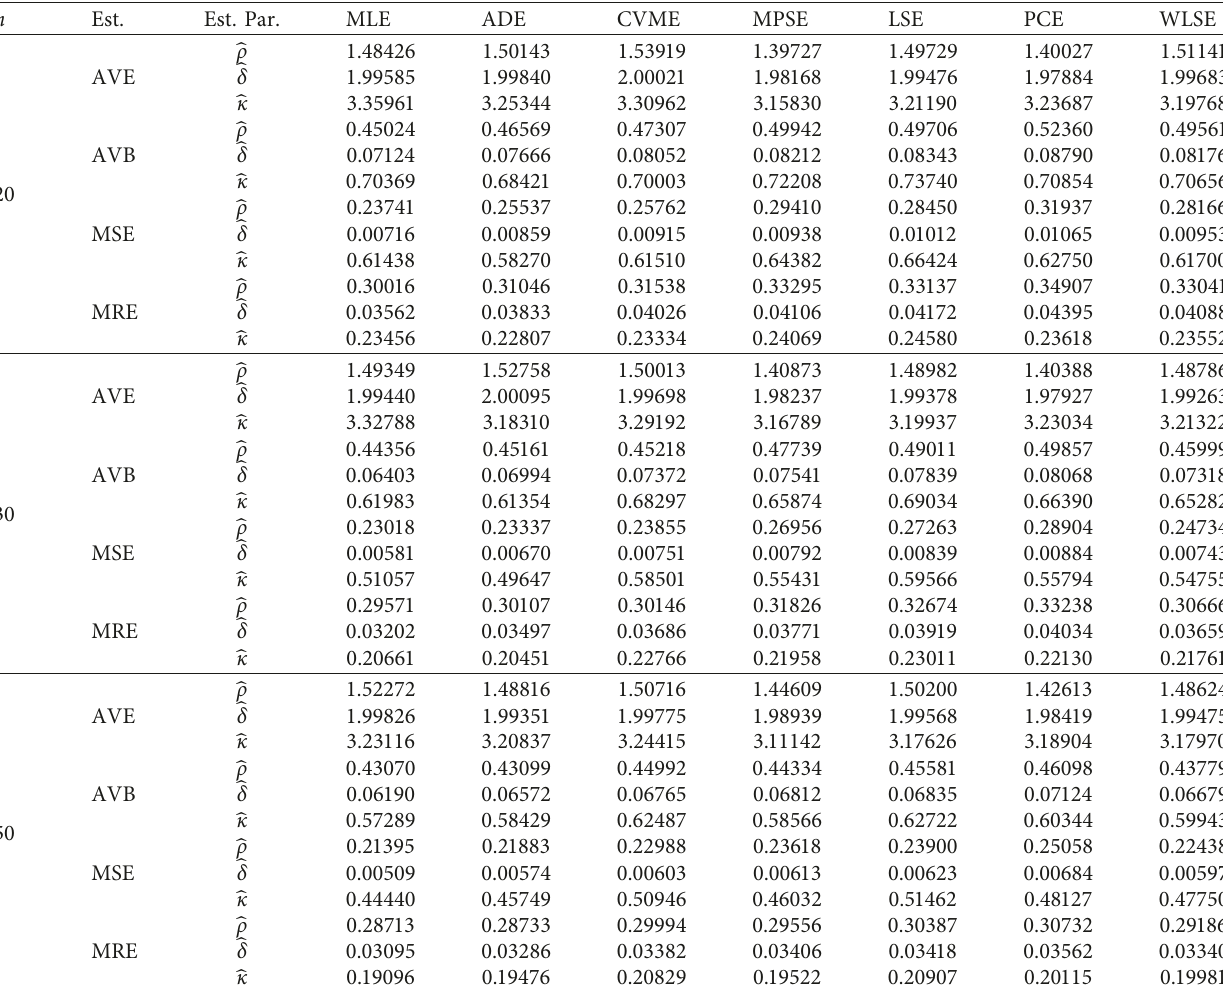
Table 5: Simulation results of the AVE, AVB, MSE, and MRE of BXLE distribution for ( ρ � 1 . 5 , δ � 2 , κ � 3 ) . n Est. Est.